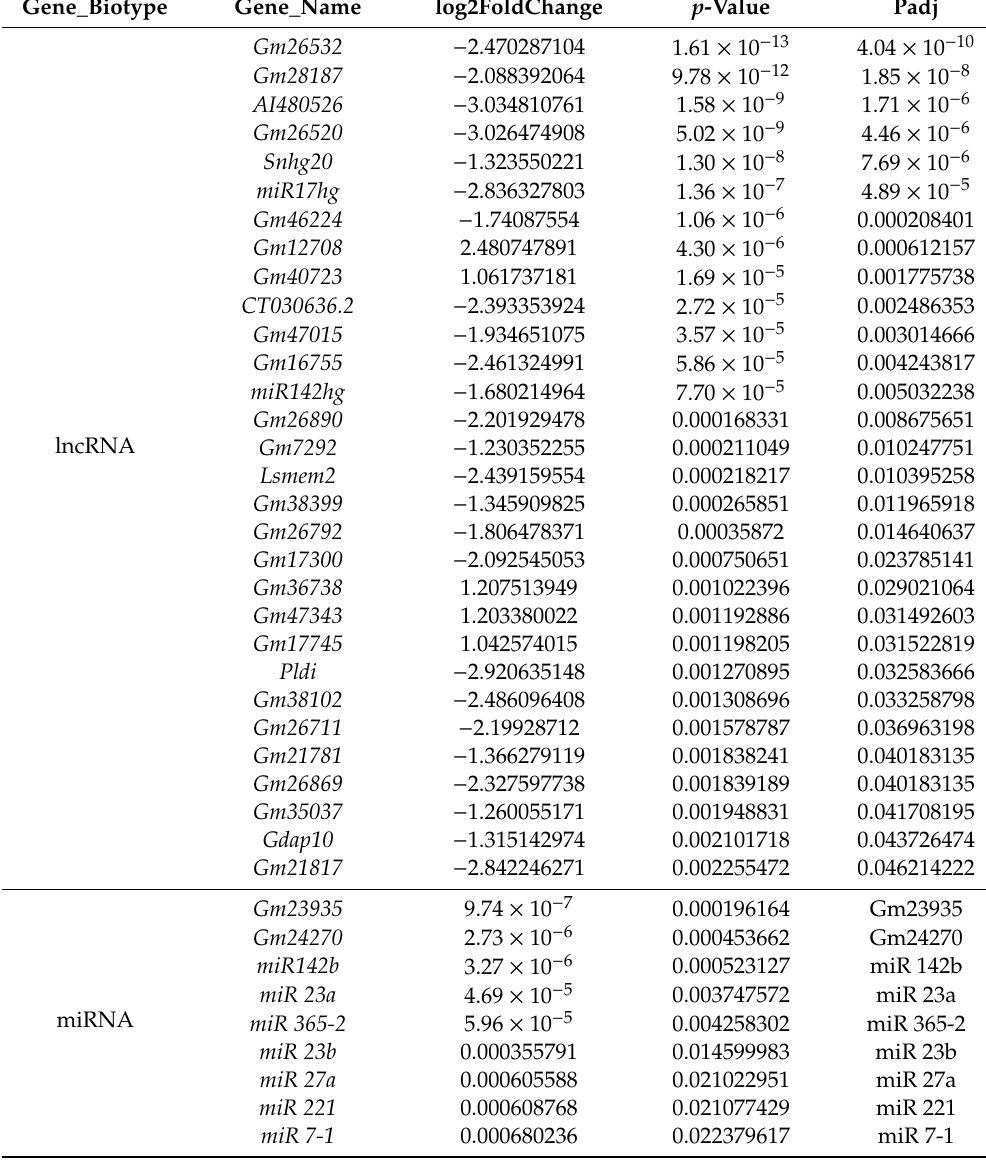
Table 1. Details of Long non-coding RNA (lncRNA) and MicroRNA